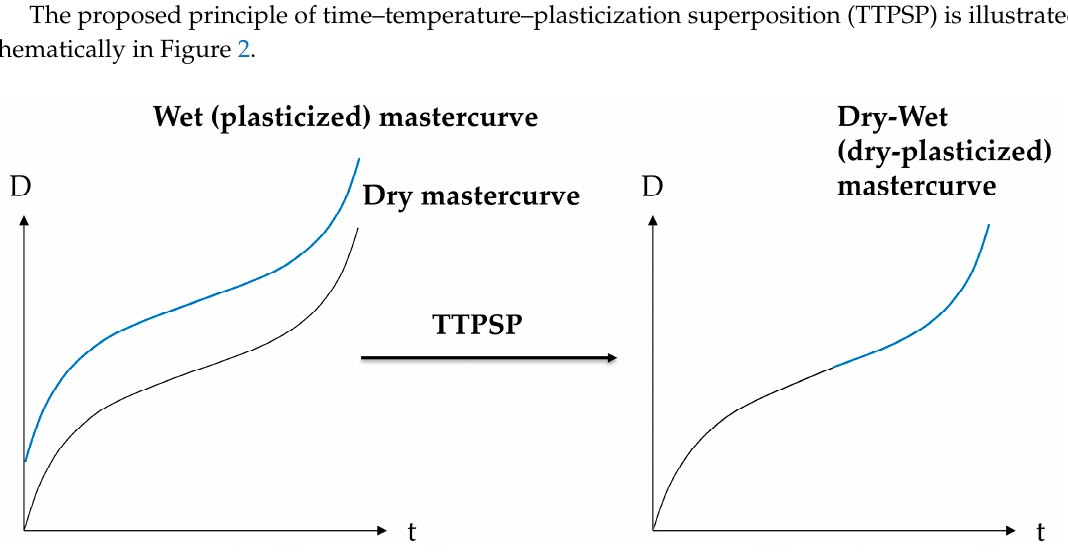
Figure 2. Schematic illustration of the proposed time (t)–temperature (T)–plasticization superposition principle (TTPSP) for the creep compliance D.